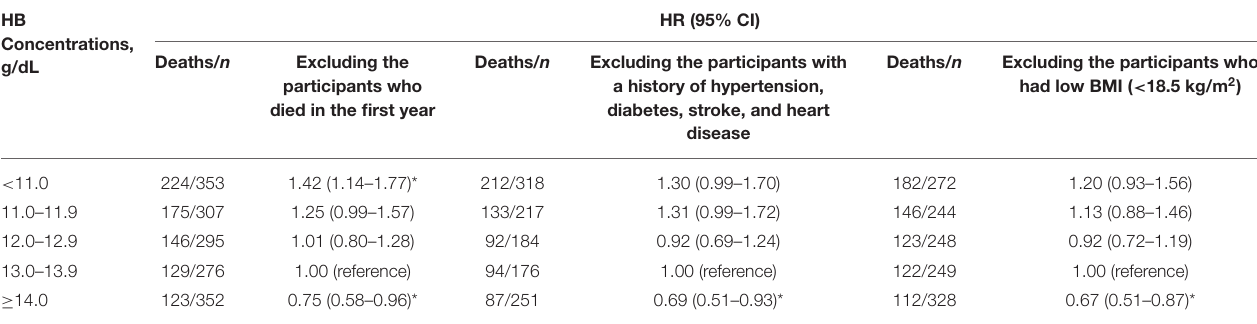
TABLE 5 | Sensitivity analyses for the relationship between HB concentrations and all-cause mortality risk in the older adults form Chinese longevity